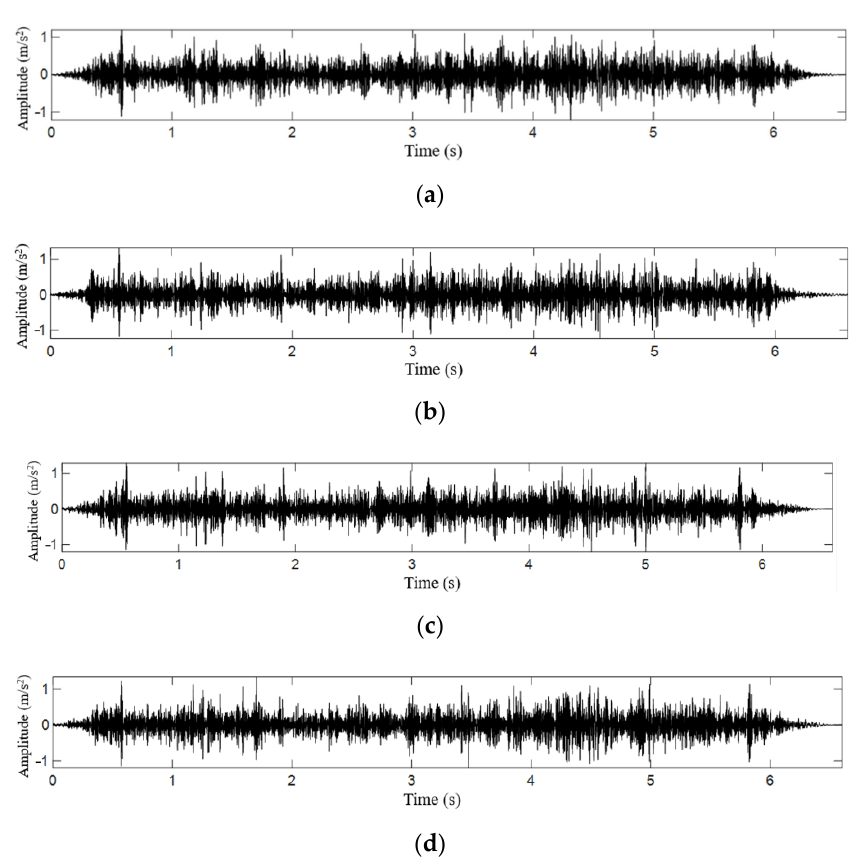
Figure 16. The original signal of vehicle acceleration corresponding to different additional mass damage: ( a ) vehicle acceleration corresponding to health state; ( b ) vehicle acceleration corresponding to Level 1 additional mass damage; ( c ) vehicle acceleration corresponding to Level 2 additional mass damage; and ( d ) vehicle acceleration corresponding to Level 3 additional mass damage.